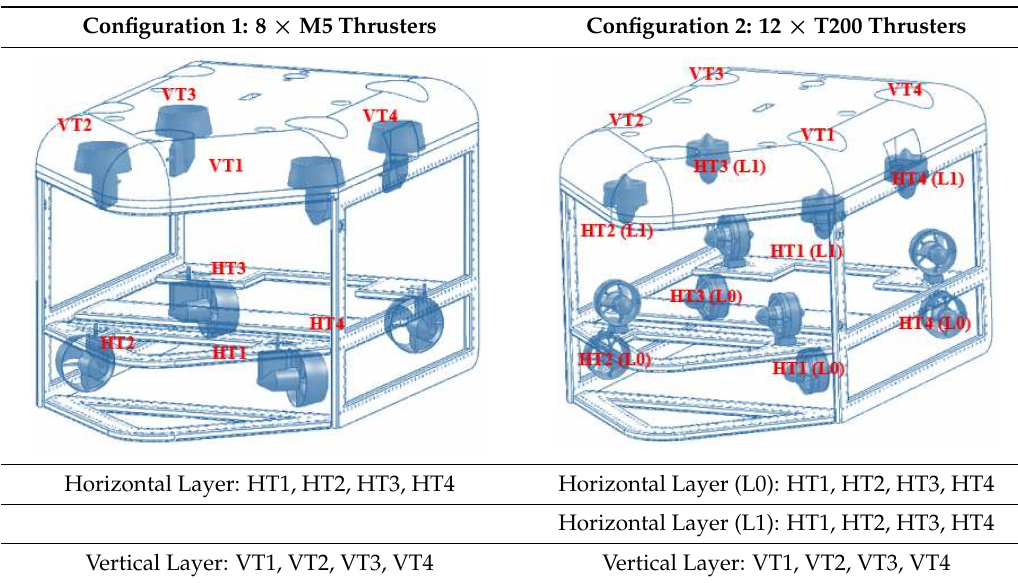
Table 1. Thruster